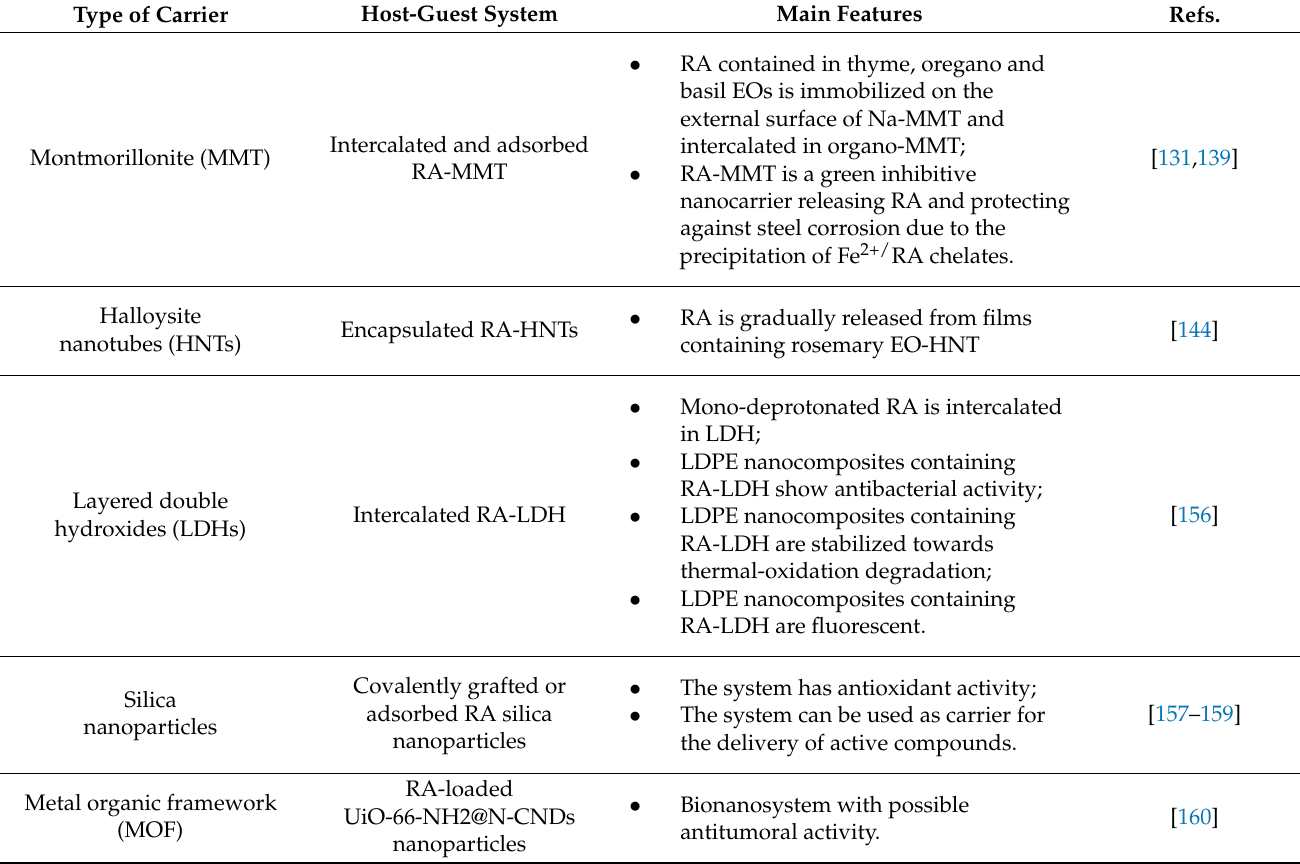
Table 2. Encapsulation of RA in in organic nano and